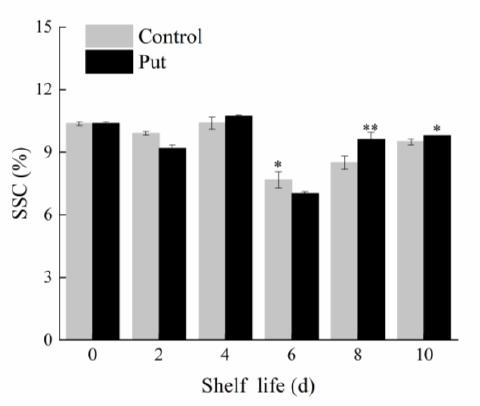
Figure 3. Changes in SSC of postharvest blueberry fruit at 20 °C. Mean ± SE of three replicate experiments are shown. Asterisks indicate significant differences between control and Put − treated fruit (* p < 0.05, ** p < 0.01).